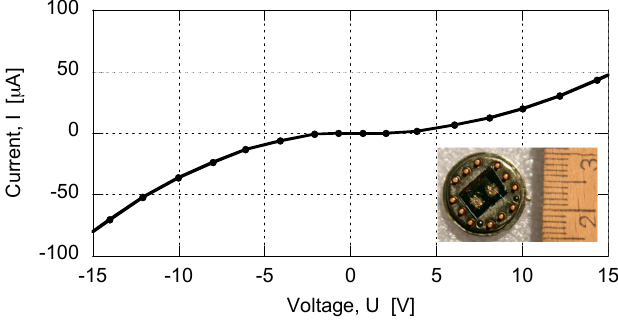
Figure 1. Current–voltage characteristic of an AuNP-based gas sensor in synthetic air. The inset depicts the sensor.